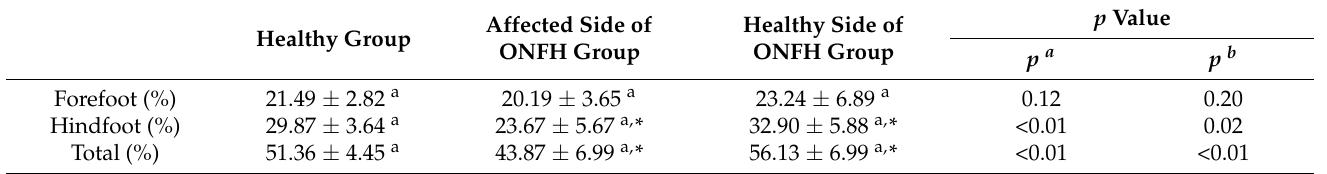
Table 3. Static plantar pressure distribution in ONFH group and healthy group.